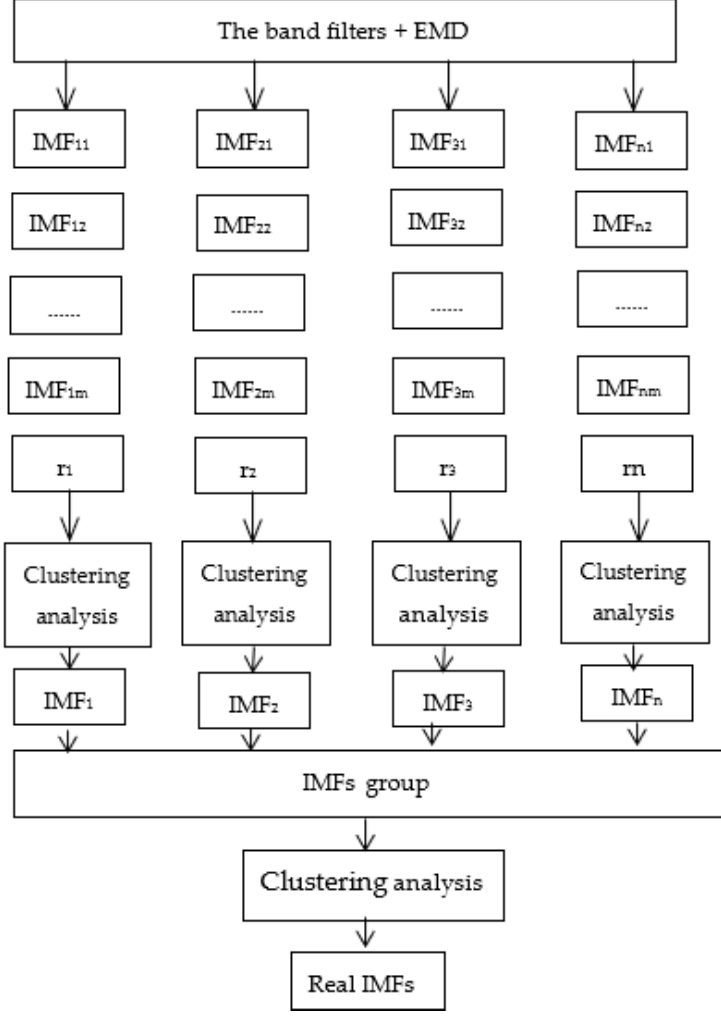
Figure 1. The proposed IEMD method.